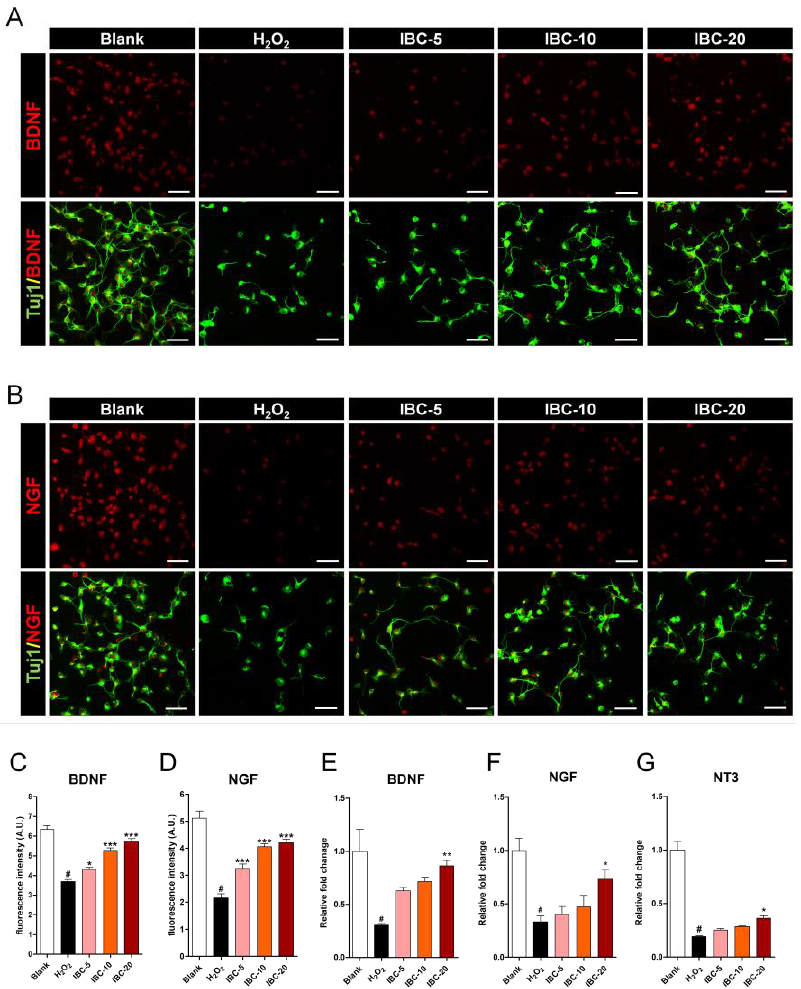
Figure 8. Effect of IBC extract on the expression of neurotrophic factors following H 2 O 2 -induced oxidative stress injury in rat primary cortical neurons. ( A , B ) Representative images of anti-BDNF ( A ) and NGF ( B ) staining. White scale bar = 50 µ m. ( C , D ) Quantifying mean fluorescence intensities of BDNF ( C ) and NGF ( D ) in each group (n = 7). ( E – G ) Gene expression associated with neurotrophic factors in cortical neurons using qRT-PCR (n = 6); ( E ) BDNF , ( F ) NGF and ( G ) NT3 . Data are expressed as the means ± SEM. Significant differences indicated as # p < 0.001 compared vs. the blank group, * p < 0.05, ** p < 0.01 and *** p < 0.001 vs. the H 2 O 2 group were analyzed via one-way ANOVA with Tukey’s post hoc test.